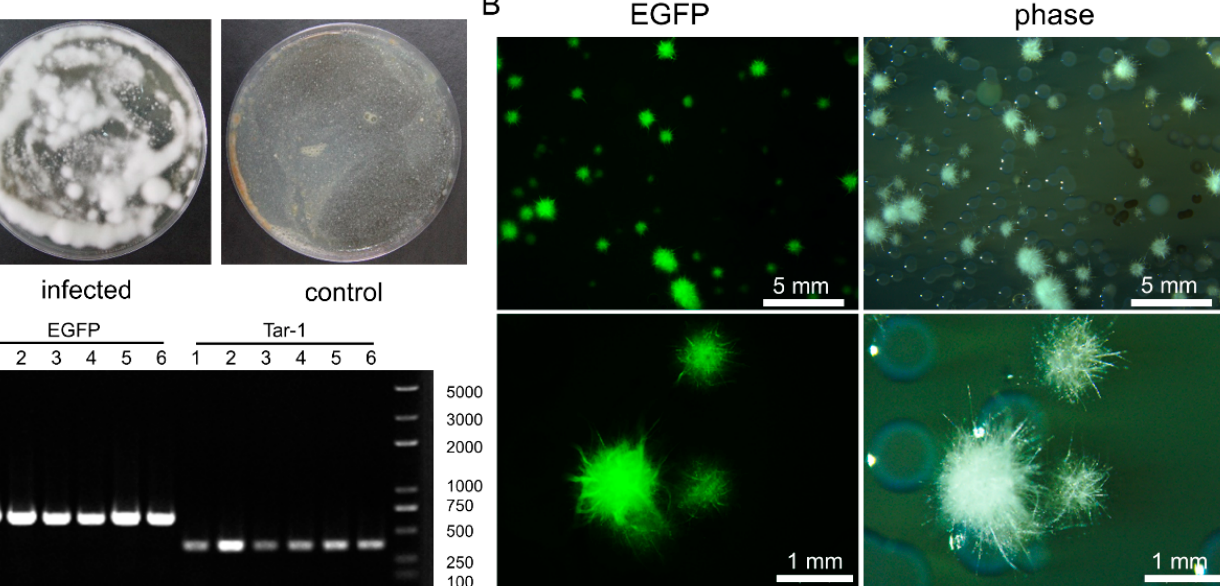
the excrement of infected and control larvae in potato dextrose agar (PDA) medium (containing PPT + , Kan + , Amp + ) at 28 °C for seven days. The excrement of uninfected larvae was used as control. ( B ) Fluorescence and white light microscopic observation of colonies on plating medium. ( C ) Fluorescent colonies were amplified by polymerase chain reaction (PCR) using EGFP and Tar-1 primers.